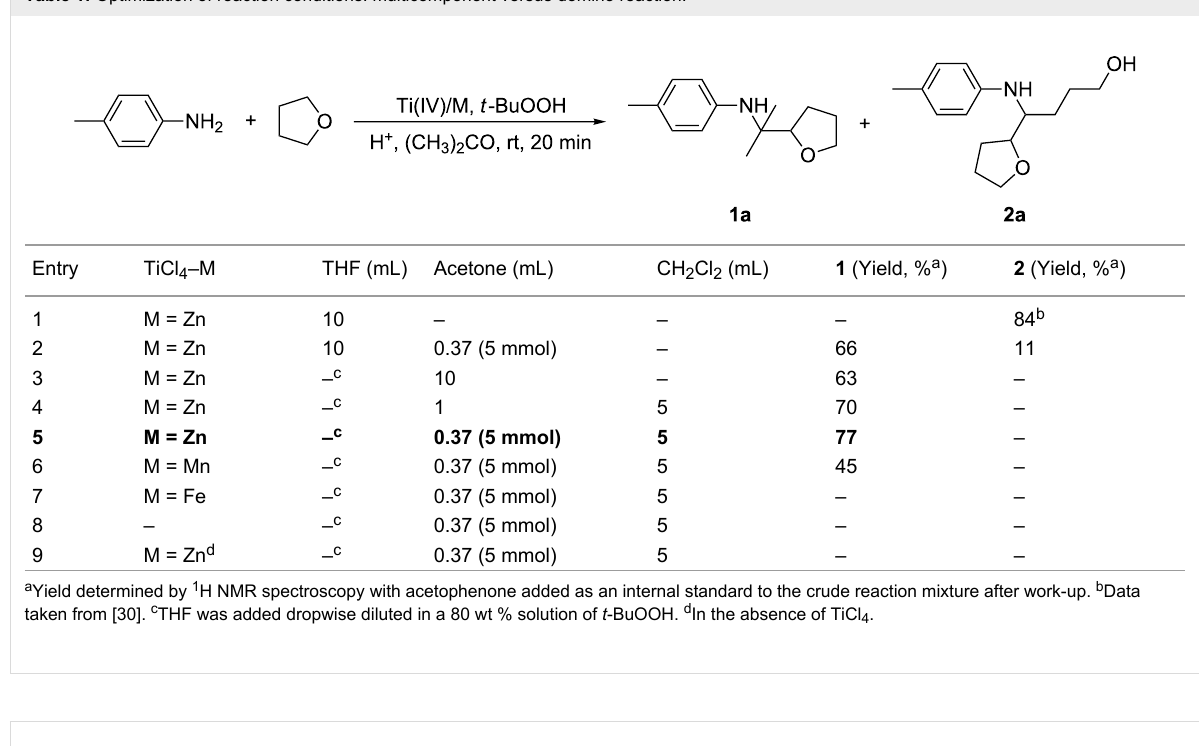
Table 1: Optimization of reaction conditions: multicomponent versus domino